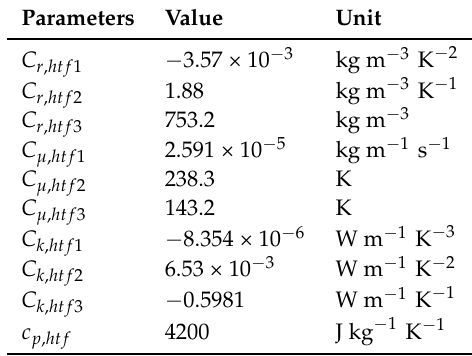
Table 2. Fitting constants for water material characteristic